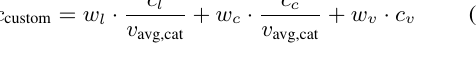
Figure 6. Mean scores of the three possible of roughness representations for different surface types. Red colored numbers indicate the worst comfort compared to the others, yellow medium comfort and green colored numbers mean highest